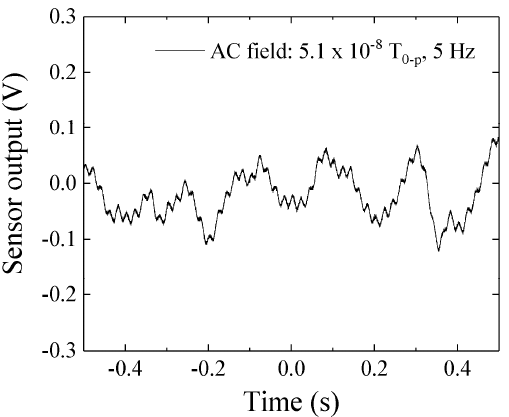
Figure 17. Measured signal when a 5.1 × 10 − 8 T 0-P in 5 Hz was applied to the sensor element.